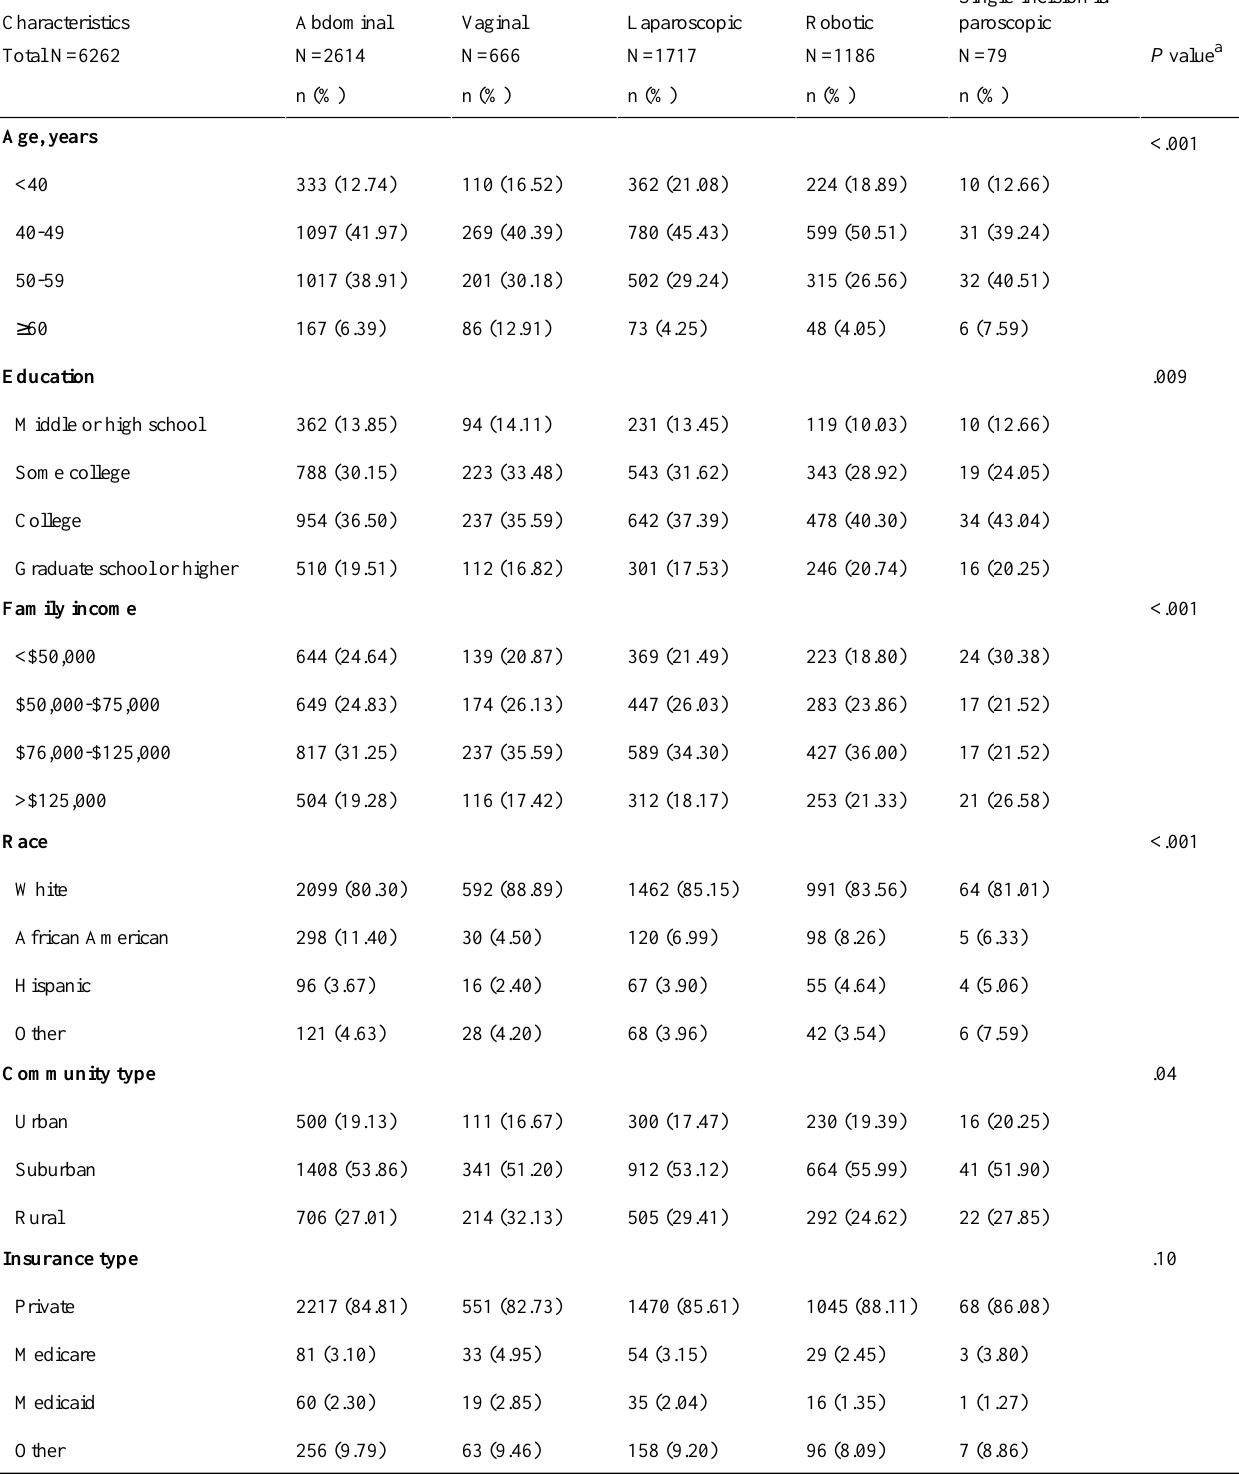
Table 1. Patient sociodemographic characteristics by surgical